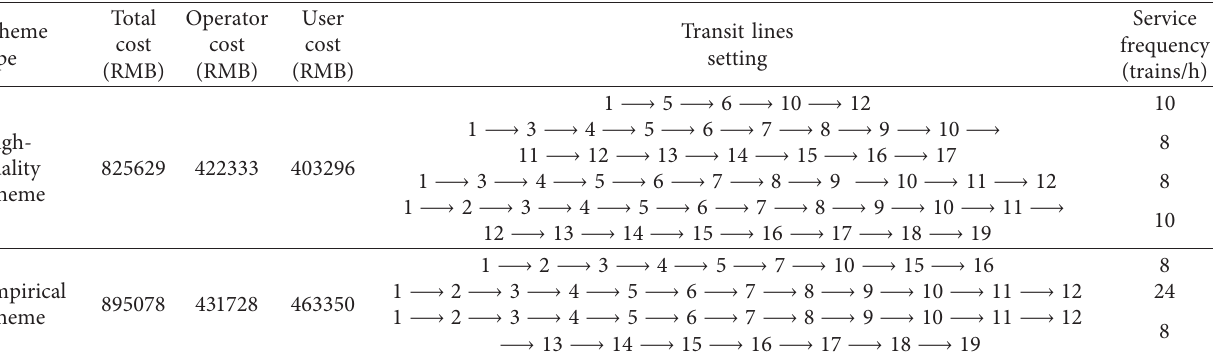
Table 5: Result comparison of the two schemes.